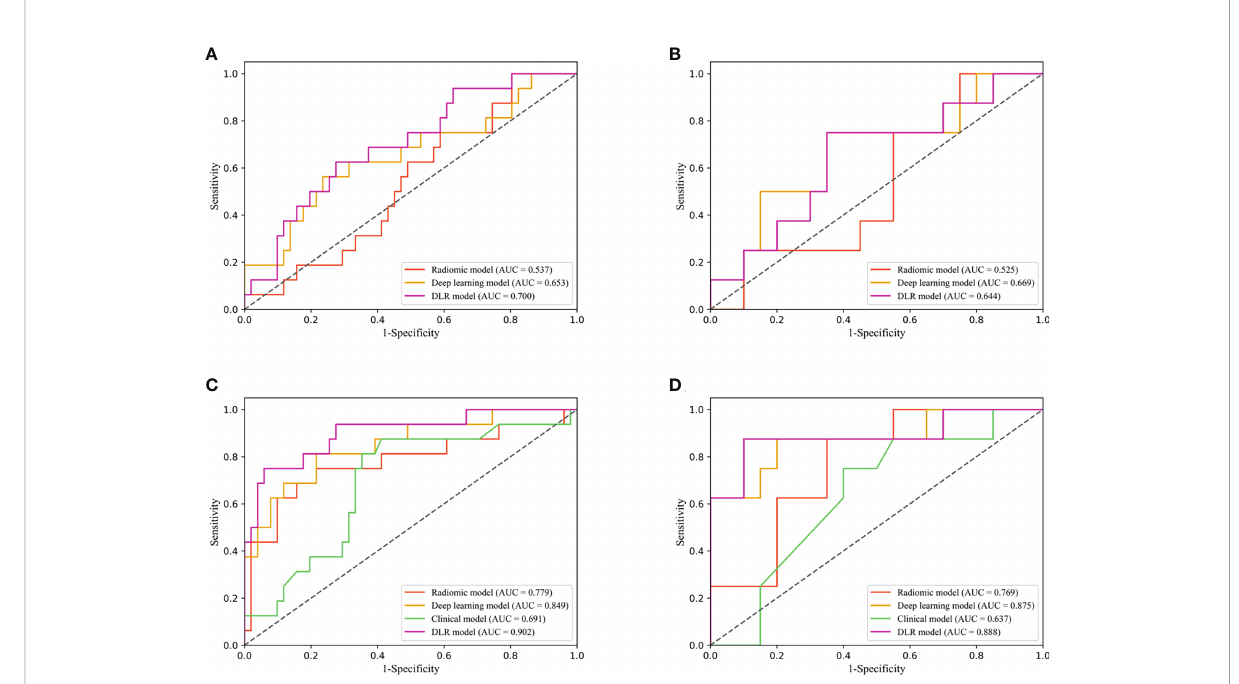
FIGURE 4 Diagnostic performance of DLR model in the training and validation cohorts. Receiver operating characteristic (ROC) curves for performance comparison of radiomics, deep learning and DLR model based on the pretreatment DCE-MRI in the training (A) and validation cohorts (B) . ROC curves for performance comparison of radiomics, deep learning, clinical model and DLR model based on the early treatment DCE-MRI in the training (C) and validation cohorts (D) .